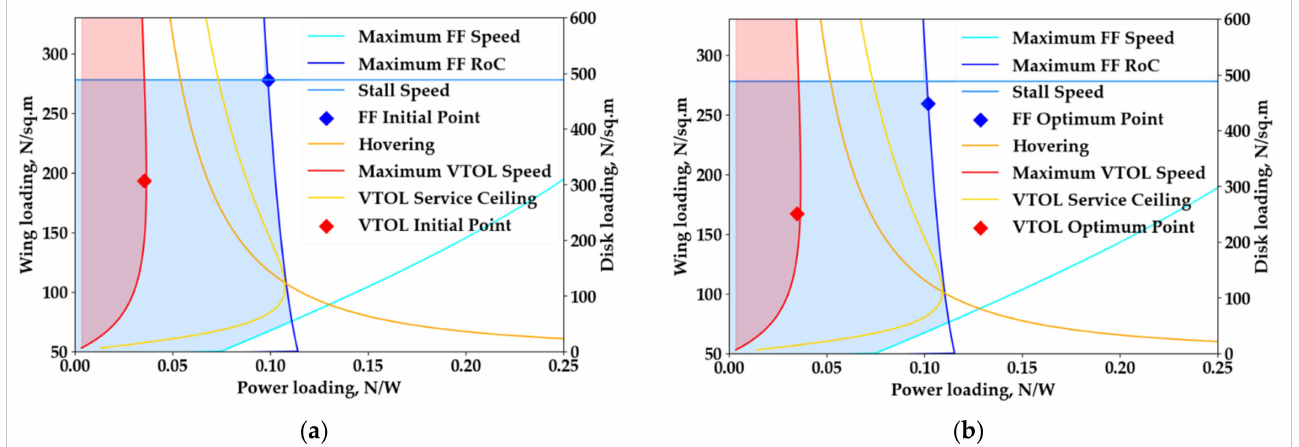
Figure 16. Initial point and optimum point in the design space defined by MCA. ( a ) is the initial point to minimize the wing span and FF/VTOL required power; ( b ) is the optimal point that minimize MTOW of UAV and satisfied all design requirements.